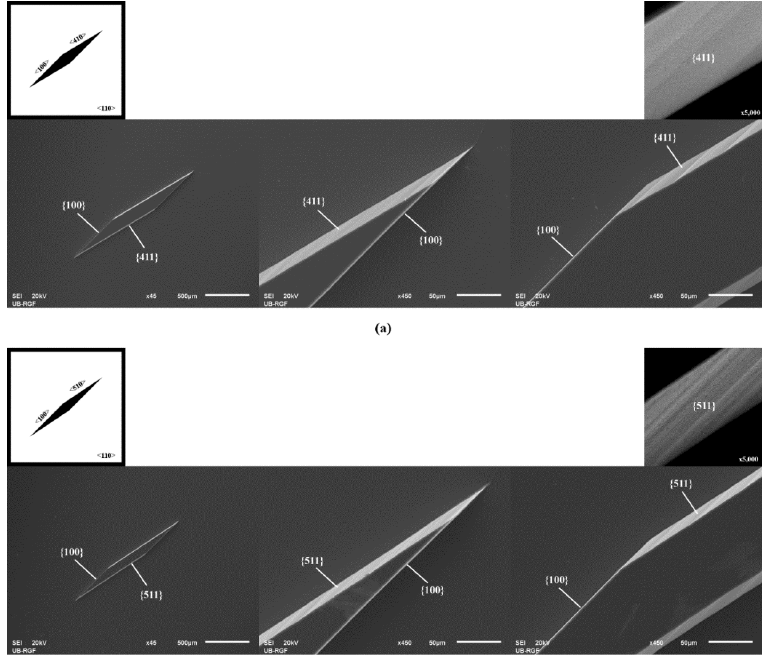
Figure 1. Schematic mask patterns and scanning electron microscope (SEM)micrographs (standard Si wafer) of the etched parallelograms with sides along < 100 > directions, ( a ) < 210 > directions and ( b ) < 310 > directions. Parallelograms are islands of the masking layer (black). Enlarged details of the etched acute and obtuse angles in the masking layer are given for both cases. Magnified {211} and {311} planes are presented.